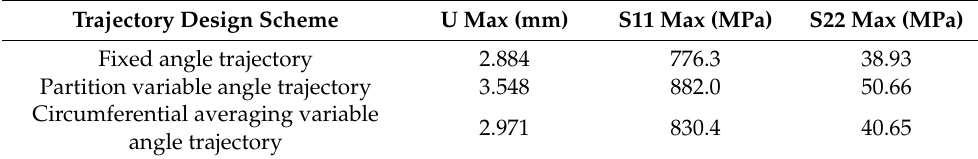
Table 3. Maximum displacement and maximum stress of different path design